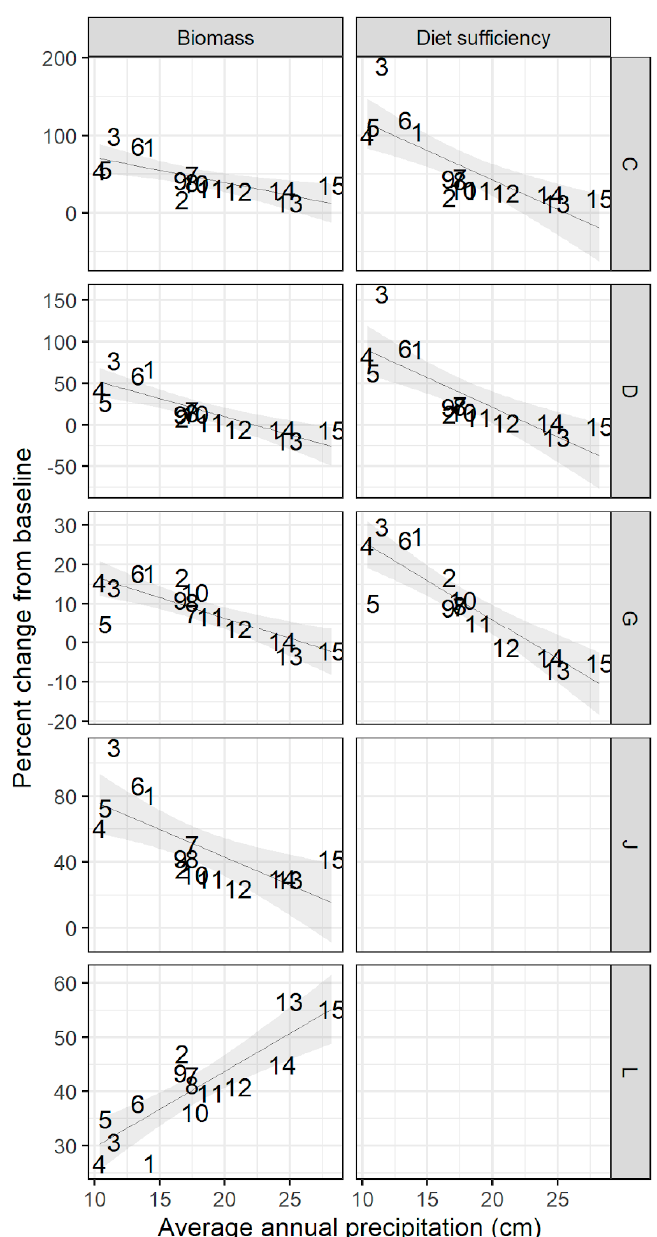
Figure A2. Percent change in standing biomass and animal diet sufficiency at 15 sites un- der fixed contrasts of altered temperature, precipitation, and animal density applied one- at-a-time. Contrast B: elevated temperature; F: elevated precipitation; H: elevated animal density; I: no grazing. Shaded area shows 95% confidence interval around best-fit line. Sites are shown here by their label from south (1) to north (15); see Figure 1 and Table A1 for site locations.